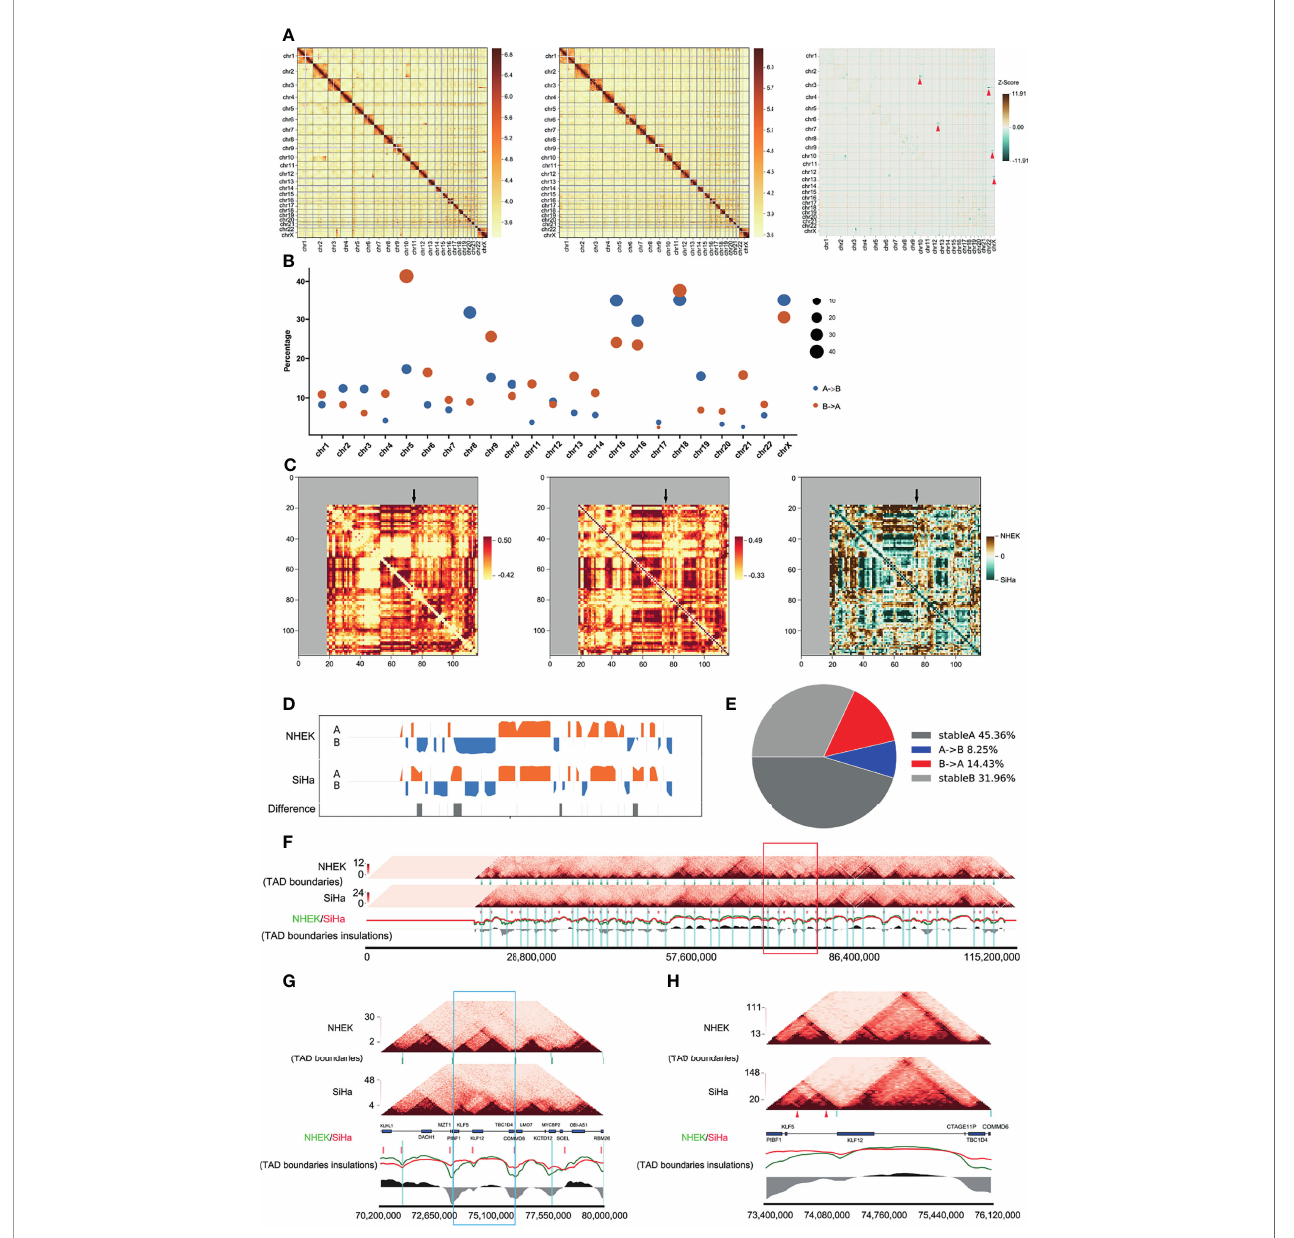
FIGURE 2 | HPV16-LINC00393 integration altered local 3D genome structure of SiHa cells. (A) Heatmaps of the genome-wide chromosomal pro fi les of two cell lines (left: SiHa, right: NHEK) and their subtraction image (SiHa – NHEK). The red arrows show the structure alternations in SiHa. (B) Bubble diagrams showing percentage of switched compartments. Sizes of bubbles indicate the number of changed compartment. (C) Heatmaps indicate contact correlation matrix for chromosome 13. Left: NHEK; middle: SiHa; right: a reduced interaction matrix between SiHa and NHEK. (D) The compartment of the chromosome 13. NHEK lies at the top and SiHa lies at the bottom. Compartment A is in orange and compartment B is in blue. (E) The pie chart indicates the compartment change in chromosome 13 of two cell lines. The proportion of compartment B in NHEK which is turned into compartment A in SiHa is shown in red and the opposite situation is in blue. (F) The local comparison of TADs in SiHa and NHEK, including the comparison of heat maps, TAD boundaries and insulations. The short green vertical line shows the TAD boundary of NHEK and the short red one shows the TAD boundary of SiHa. The long blue vertical line is the TAD boundary of NHEK, which is used as a reference. The red (SiHa) and green (NHEK) wavy lines indicate the insulation scores of the two cells. The black and grey areas at the bottom represent the difference between NHEK and SiHa insulation scores. The red box represents the fi ve TAD boundaries near the integration area. (G) The fi ve TADs near the integration area shown in the red box of 2F. The blue box is the TAD boundaries in the integrated region. This TAD has a new TAD boundary and is divided into two smaller TADs in SiHa. (H) The details of the blue box in 2G. The reference gene above the scale is from NCBI (Chr13, 73400000 – 746120000). A new TAD boundary appears in SiHa shown by a blue vertical band. The genome integration sites of SiHa are triangulated in red. The TAD on the left has a tendency to split into two sub-TAD